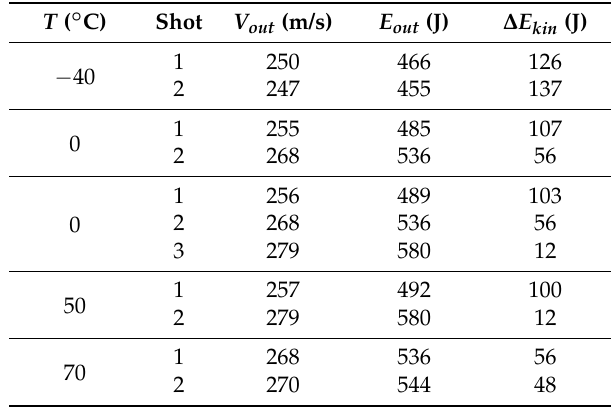
Table 3. Variation of kinetic energy after multiple perforations ( V in 282 m/s, E in 592 J). T (°C)